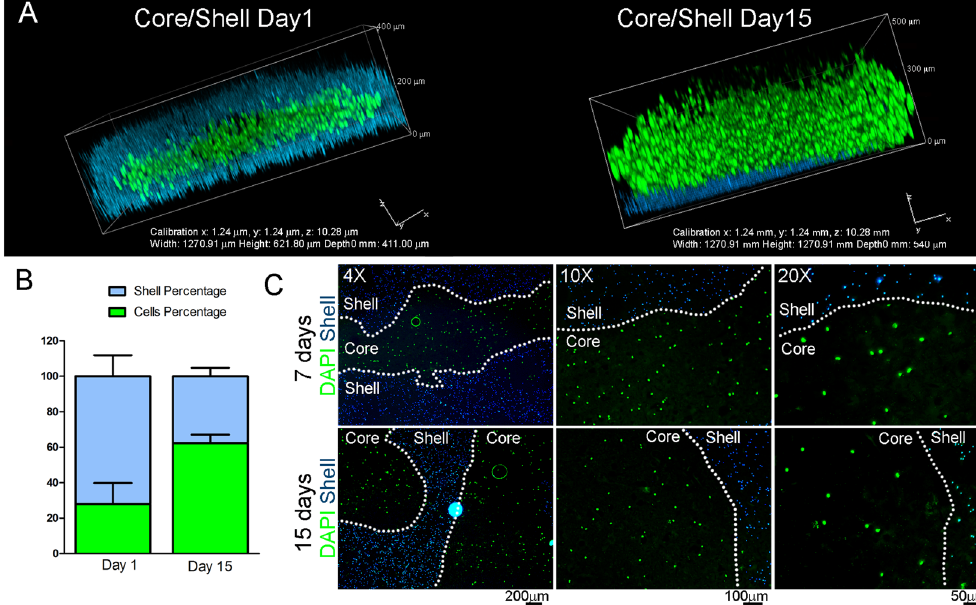
Figure 6. The Core/Shell design allows cells to proliferate. ( A ) Representative 3D rendered confocal images of ADSCs bioprinted samples stained with Calcein-AM (live cells, green channel) at day 1 and day 15 after printing. The Core/Shell samples were generated by labeling with fluorescent beads the Shell (GelMa/HAMa plus LAP 0.1%, cyan channel). z -stacks were acquired every 10 μ m and 3D rendering was performed with NIS elements software using the Alpha - blending algorithm. A Nikon Plan Fluor 10x DIC L N1 NA0.3 objective lens was used. Images show representative 3D rendered of superimposed (merge) cyan and green channels of confocal single 2D z -stacks. ( B ) The graph shows the representation of the percentages of the same area occupied by cells (Cells percentage) and Shell (Shell percentage). ( C ) Fluorescence images of 10 μ m cryosections obtained from the cryopreserved bioprinted samples. The cyan channel represents the labeled Shell, while cells have been stained with DAPI before imaging. A fluorescent Olympus IX70 inverted microscope with a SPOT Diagnostic RT-Slider camera and SPOT Diagnostic software was used. Olimpus 4X UPlanFL NA0.13, 10X CPlanFL RC NA0.3 and 20X LCPlanFL RC2 NA0.4 objective lenses were